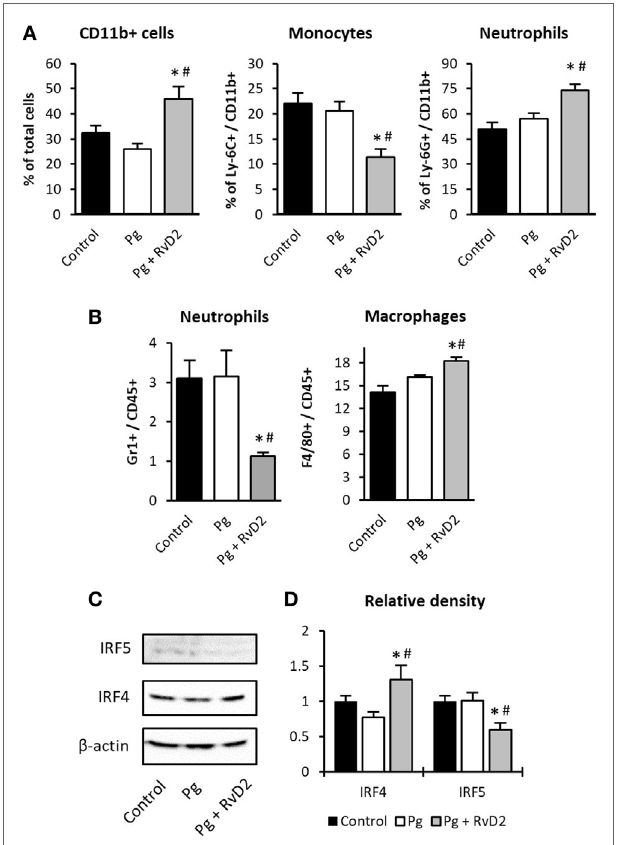
FigUre 5 | Resolvin D2 promotes resolution of the inflammatory environment in the gingiva and in the lymph nodes by regulating the expression of pro and anti-inflammatory cytokines. Four days after the last exposure, soft gingival tissues and lymph nodes were processed for RNA extraction, (a) gingival IFN- γ , IL-1 β , TNF- α , and IL-10 mRNA expression levels were quantified and presented using real-time q PCR analysis (gene/ TBP). (B) Analysis of the kinetics of IFN- α mRNA levels in the gingival soft tissue. (c) Expression of IL-10, IL-17, and TGF- β (gene/ β -actin) in the lymph nodes. The presented data represent the means of five mice per group ± SEM. Results are representative of two independent experiments, * p < 0.05 relative to control group. # p < 0.05 relative to Pg group.